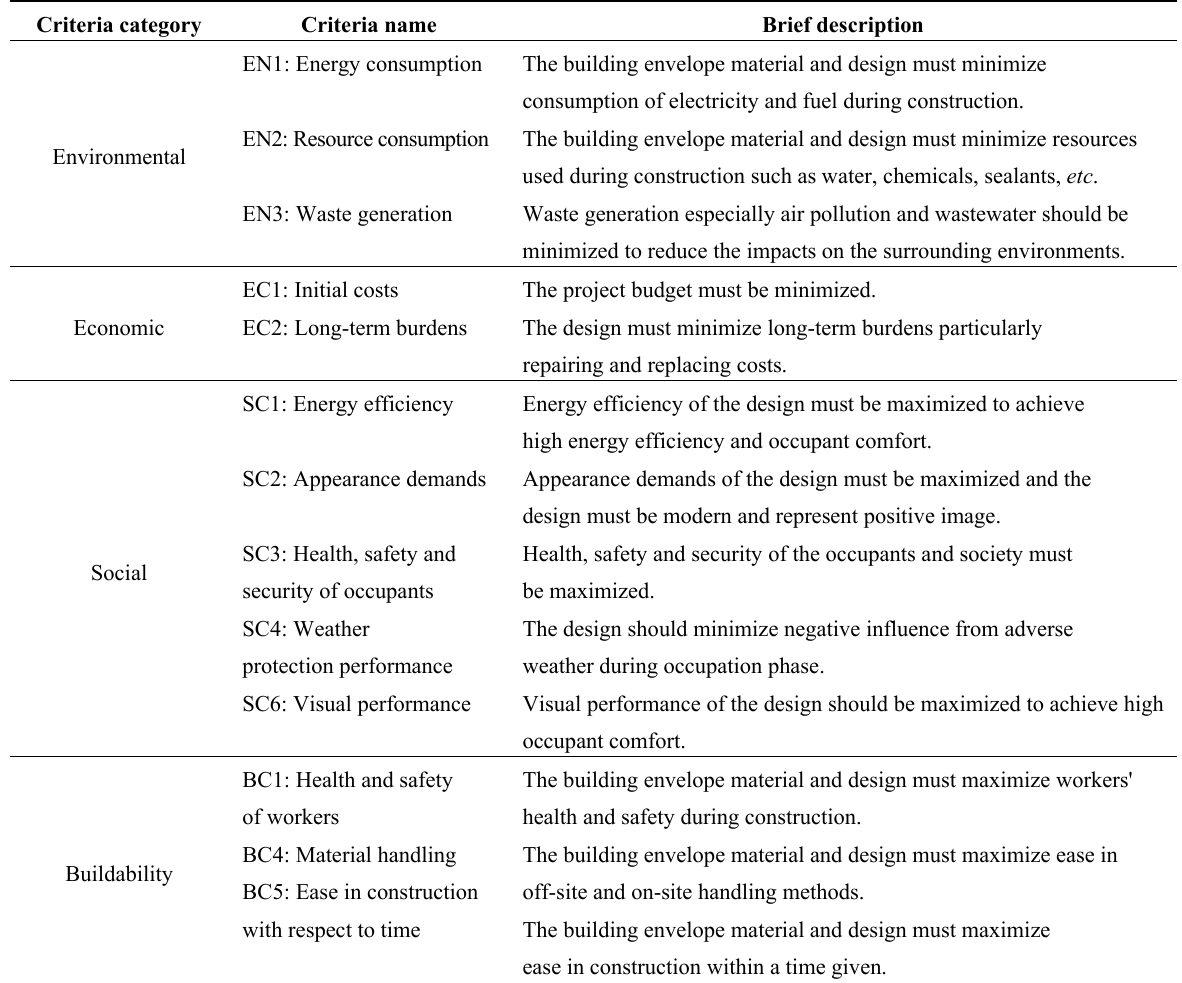
Table 3. Project key